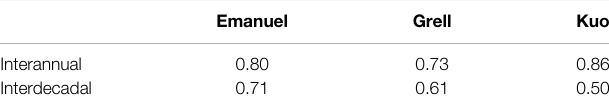
TABLE 2 | Correlation coef fi cients of interannual and interdecadal changes of simulated Yangtze Meiyu with